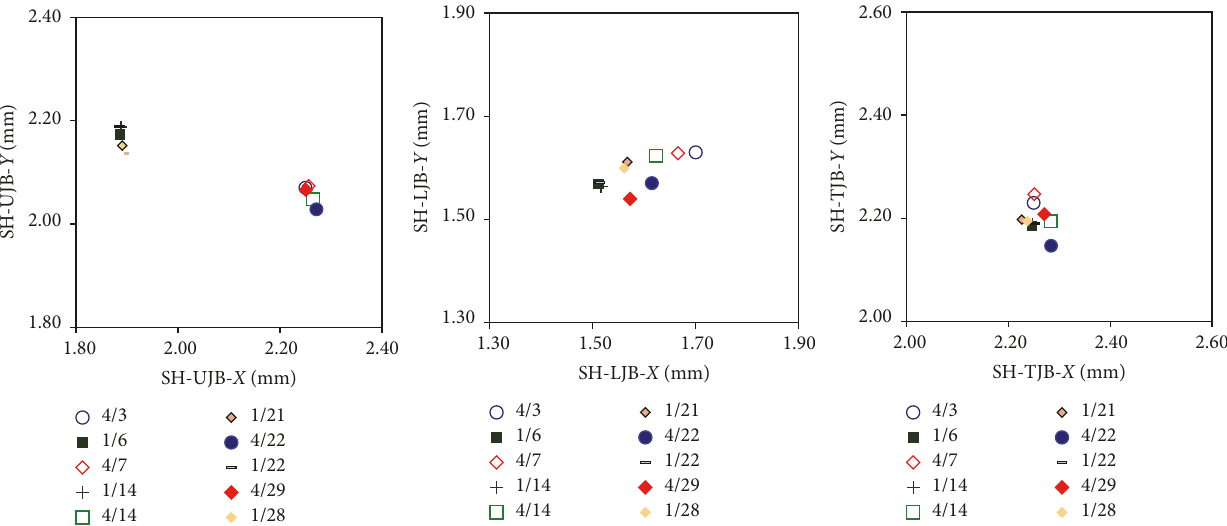
Figure 2: Shaft eccentricity in the upper, lower, and turbine journal bearings of a 700 MW hydrogenerator, measured during several